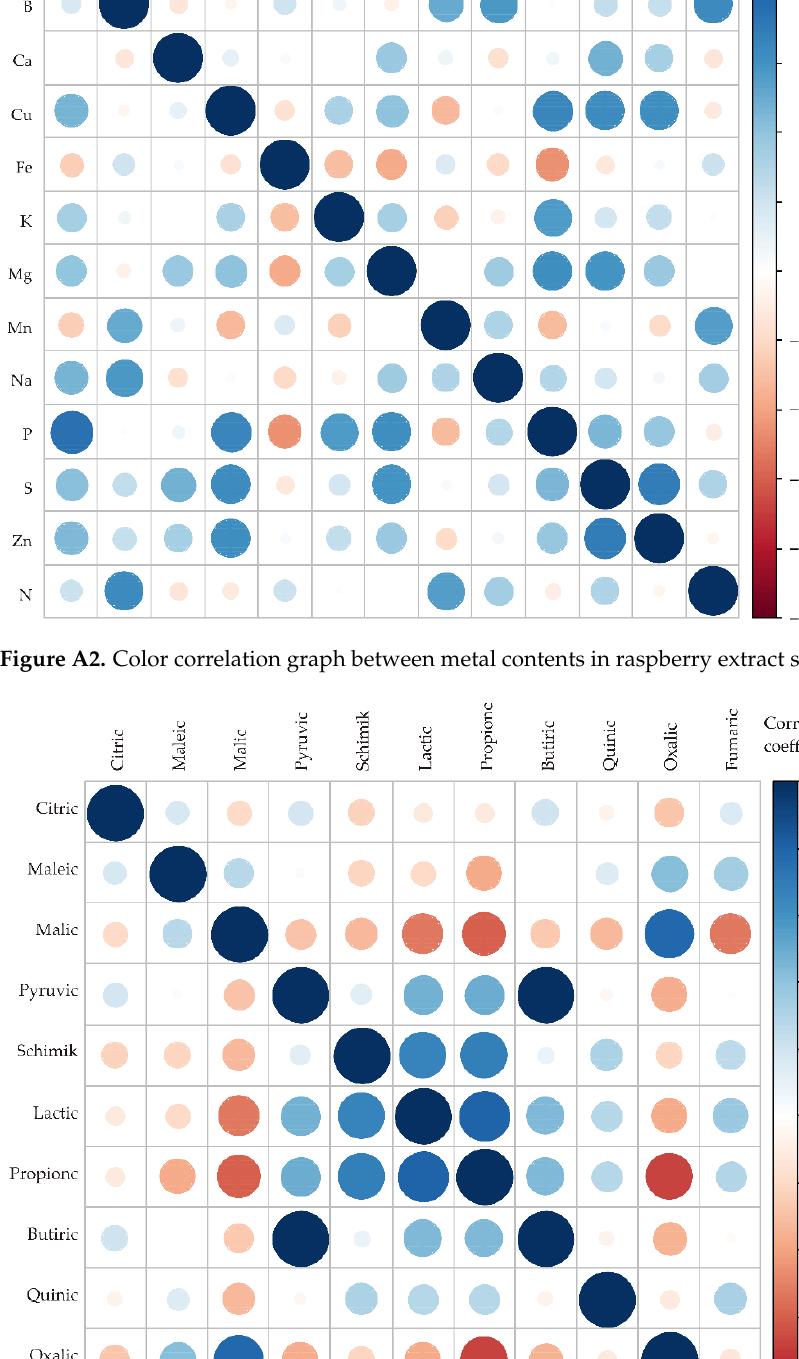
Figure A3. Color correlation graph between fruit acid contents in raspberry extract samples.